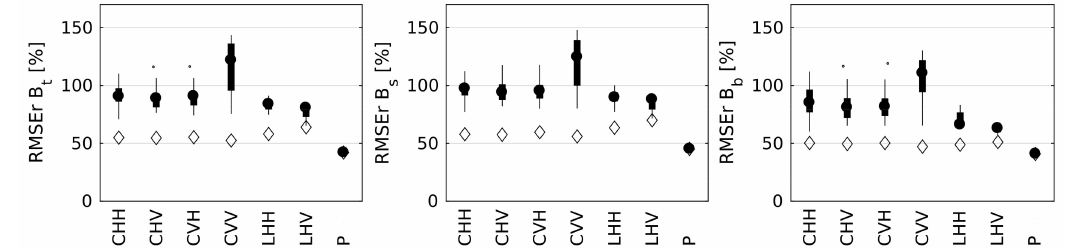
Figure 6. Relative RMSE (RMSEr) of above-ground ( left ), stem ( center ), and branch ( right ) biomass with respect to the inventory at plot level for single- and multi-image retrieval. Retrieval statistics are grouped for each given combination of frequency and polarization. In the case of P-band, a retrieval model based on HH, VV, and HV polarizations was used, which is why results are not reported per polarization. For the single-image retrievals, the black circles denote the median RMSEr, the thick lines represent the inter-quartile range of RMSEr, and the thin lines the span of RMSEr values. The diamonds ( ♦ ) denote the multi-temporal retrieval